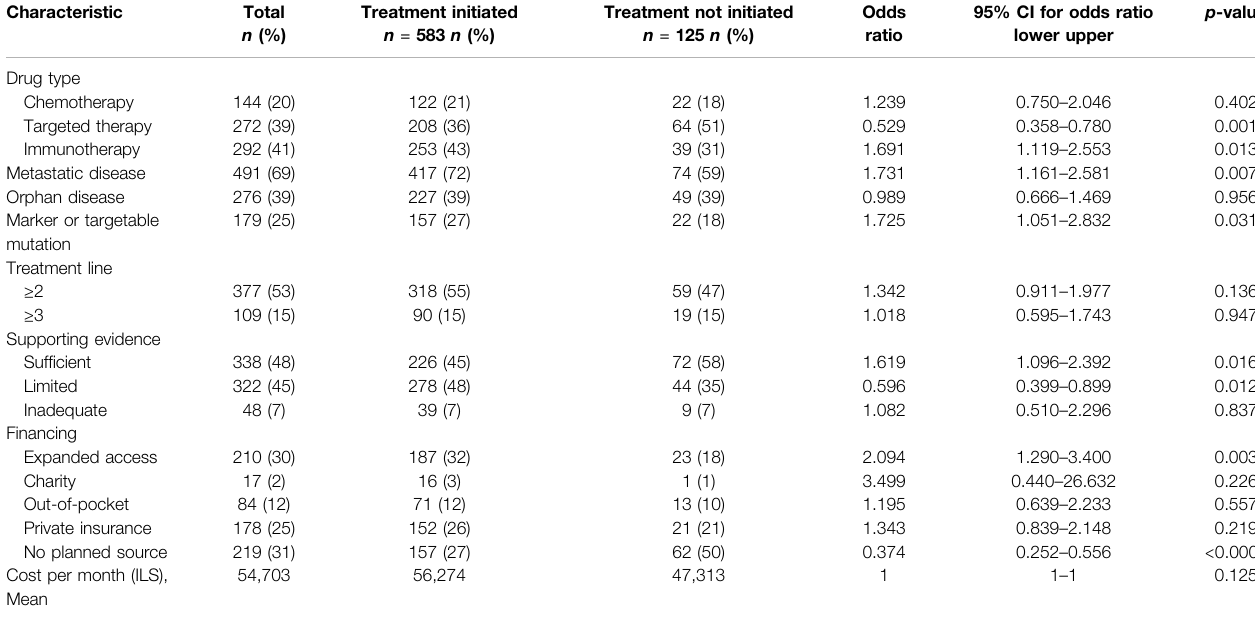
TABLE 2 | Off-label request characteristics and univariate logistic regression analysis for treatment initiation ( n (cid:1) 708).